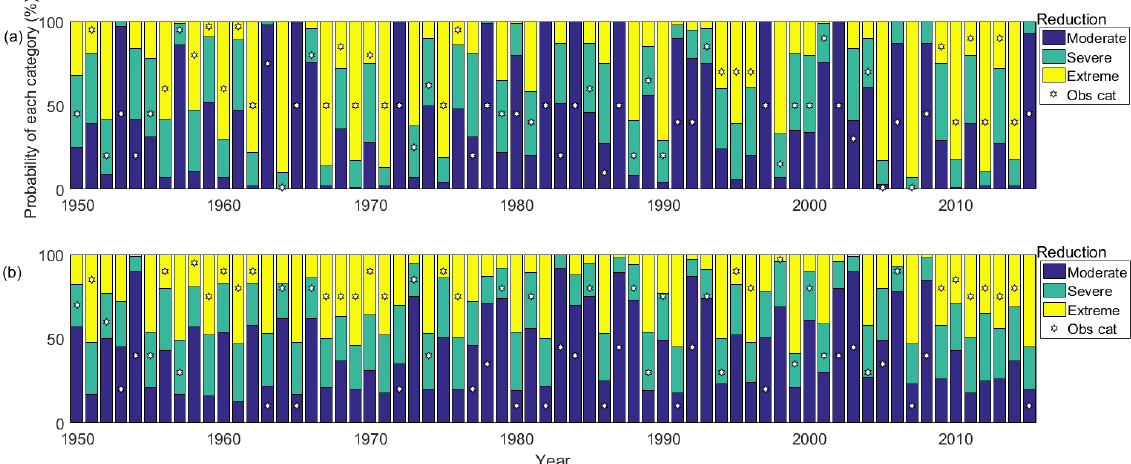
Figure 9. Probabilistic water right allocation forecast using (a) 1 September PCR-Stat model 80th percentile and (b) long-term averages (climatology).